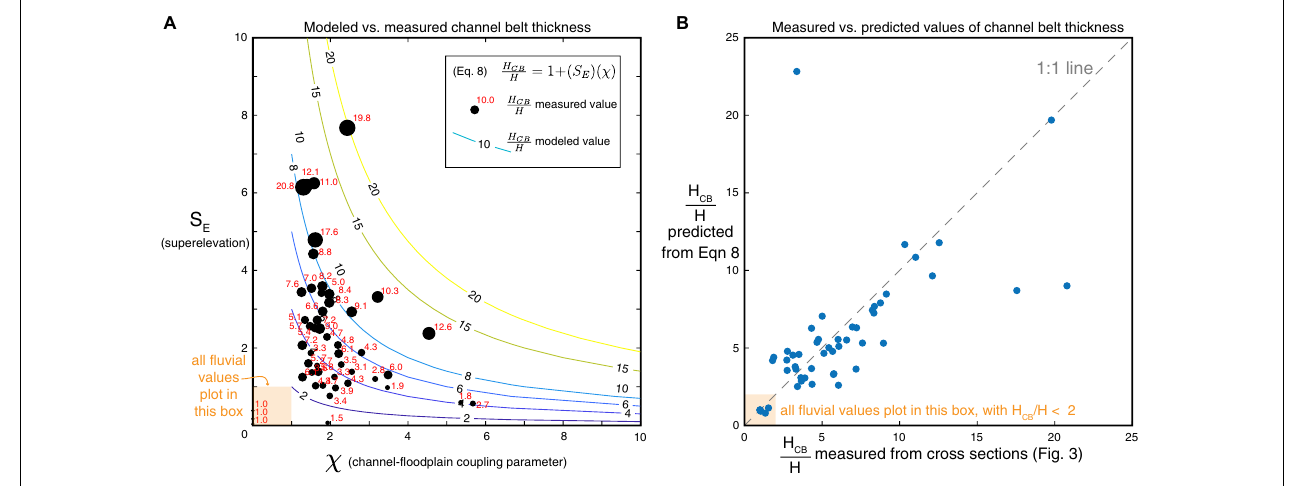
FIGURE 7 | Comparing normalized channel-belt thickness (H CB /H) values measured from submarine channel cross-sections to values of H CB /H modeled using Eq. 8 from this study. Note in both plots the position of fluvial values. (A) Plot of S E vs. χ , with colored contour lines showing H CB /H computed using Eq. 8 and the black bubbles and red text indicating the measured H CB /H values. P 80 values of S E rarely exceeds 3.4 and P 80 χ values rarely exceed 2.5. (B) Plot of measured H CB /H values against computed H CB /H values using Eq. 8. There is good agreement between measured and computed values of submarine H CB /H. Also note that the avulsion threshold for submarine channels is approximately H CB /H = 9.5; the majority of this study’s data plots below this